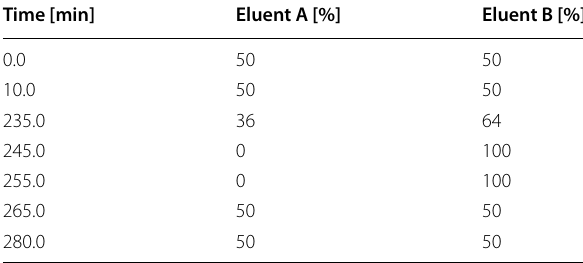
Table 3 Gradient program of P188